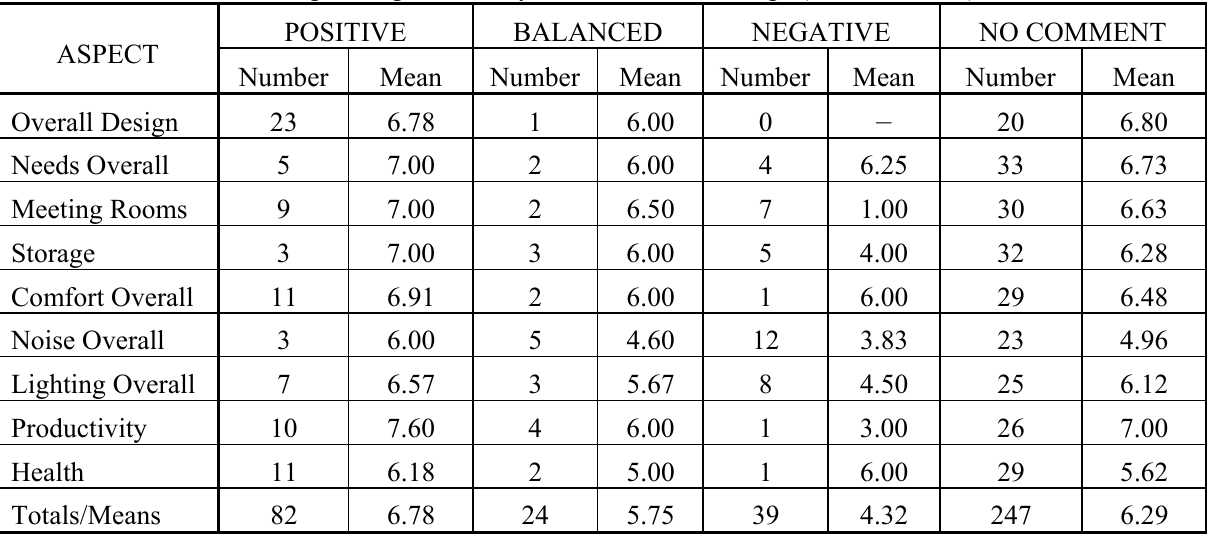
Table 4. Number and nature of comments and corresponding average scores for two case